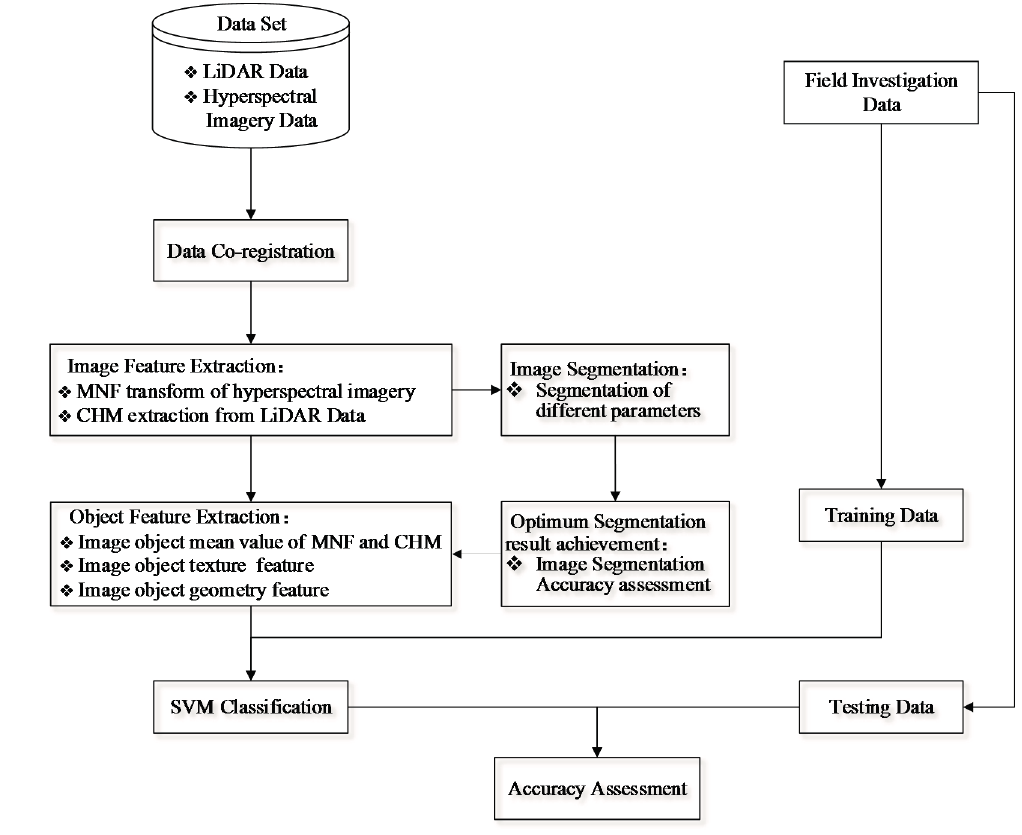
Figure 3. Flowchart of crop species classification